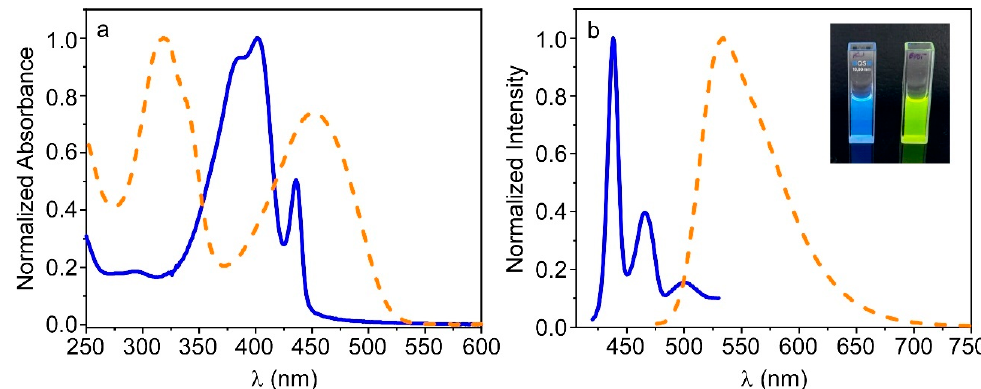
Figure 1. Normalized UV-Vis absorption ( a ) and fluorescent emission spectra ( b ) of PFO_CNPs (blue solid line) ( 𝜆 x = 396 nm) and F8BT_CNPs (orange dashed line) ( 𝜆 x = 466 nm) in buffer. Inset in ( b ) shows a picture of the PFO (left) and F8BT (right) fluorescent CNPs.